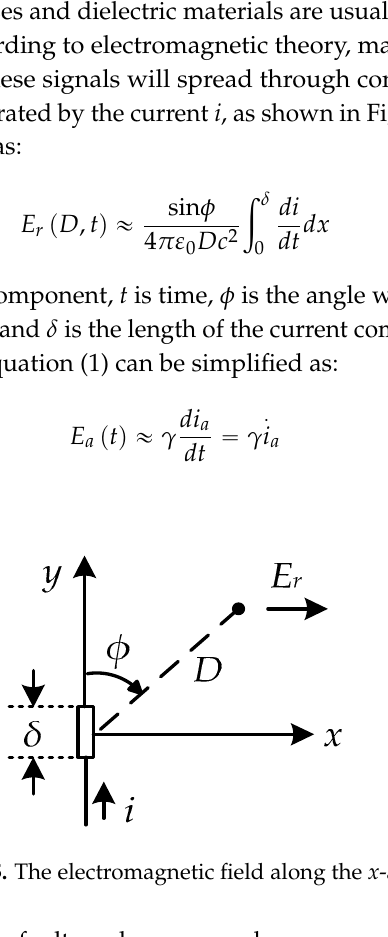
Figure 4. The HFT schematic.